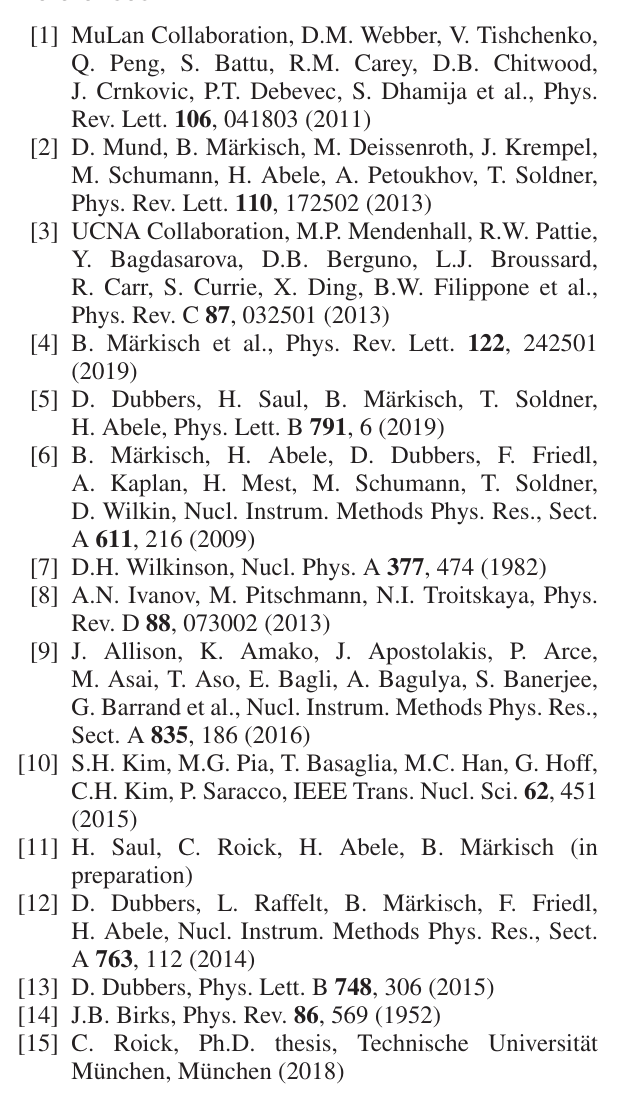
Figure 5. Undetected backscattering to the opposite detector decreases the measured asymmetry and therefore leads to a relative correction with positive sign. Solid lines show the correction without energy reconstruction, dashed lines show the correction when the energy information of the undetected impact is not lost. The dotted line shows an estimation with very simple assumptions about the detector response, e.g. without non- linearity and a simplified trigger function. Table 1. Overview of systematic uncertainties in the